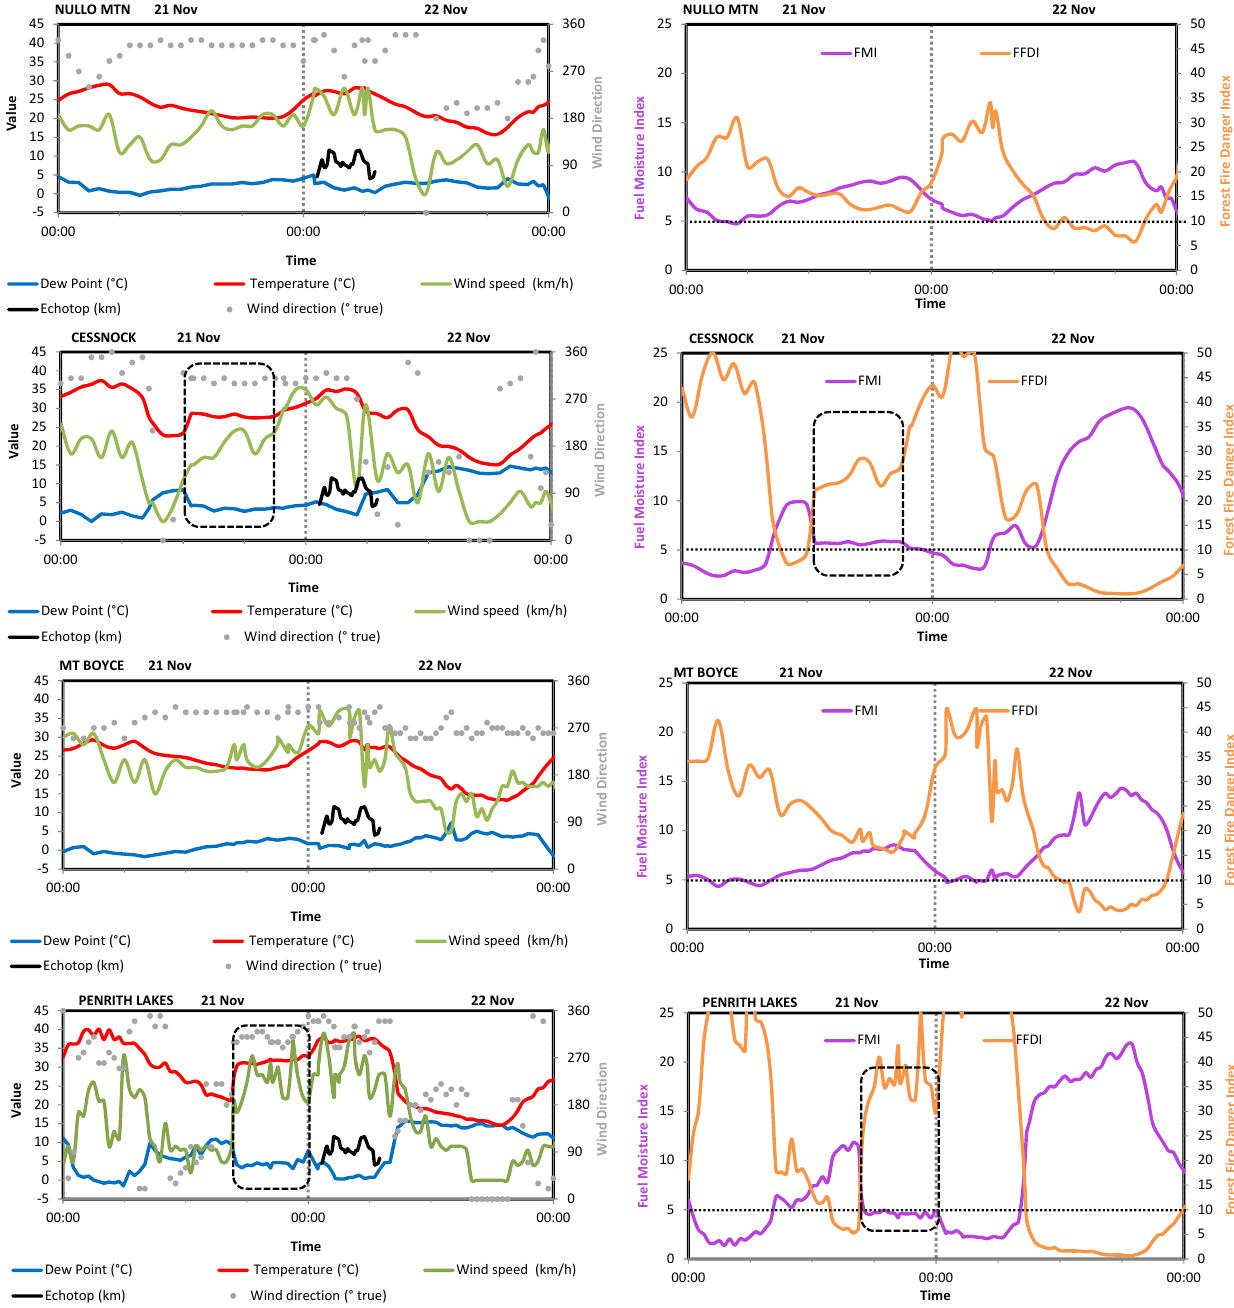
Figure 2. Weather graphs for four AWSs in the region, with surface weather (left-hand panels) and fire weather (right-hand panels). Dotted horizontal lines indicate FMI = 5. For Cessnock and Penrith Lakes, the black dotted outlines highlight the nocturnal foehn event. The echotop time sequence (see Fig. 4 for detail) is included for cross-reference